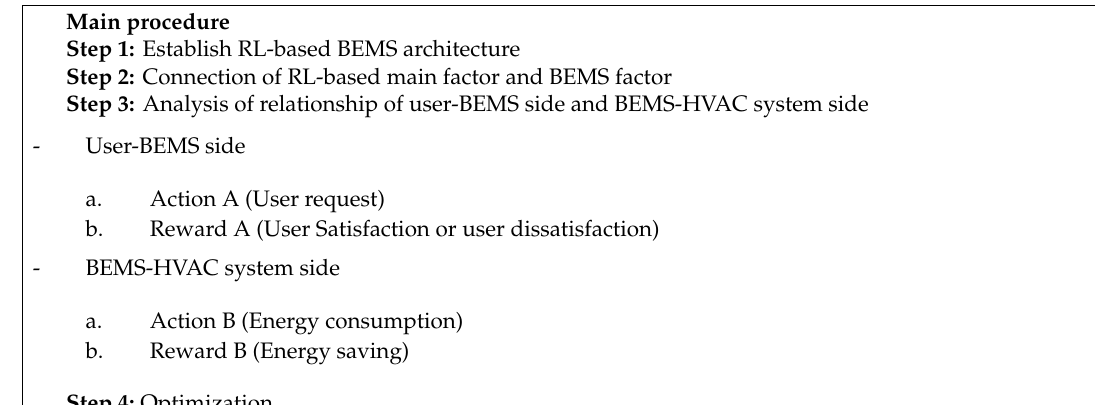
Table 2. Relationship between the Agent and Environment in the BEMS.